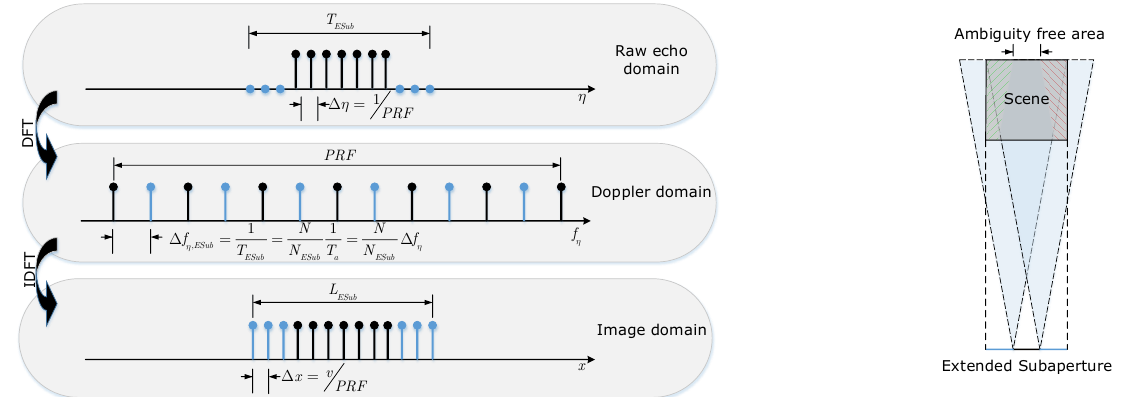
Figure 4. The extended subaperture processing. ( Left ): relationship between different signal spaces; ( Right ): extended subaperture observation